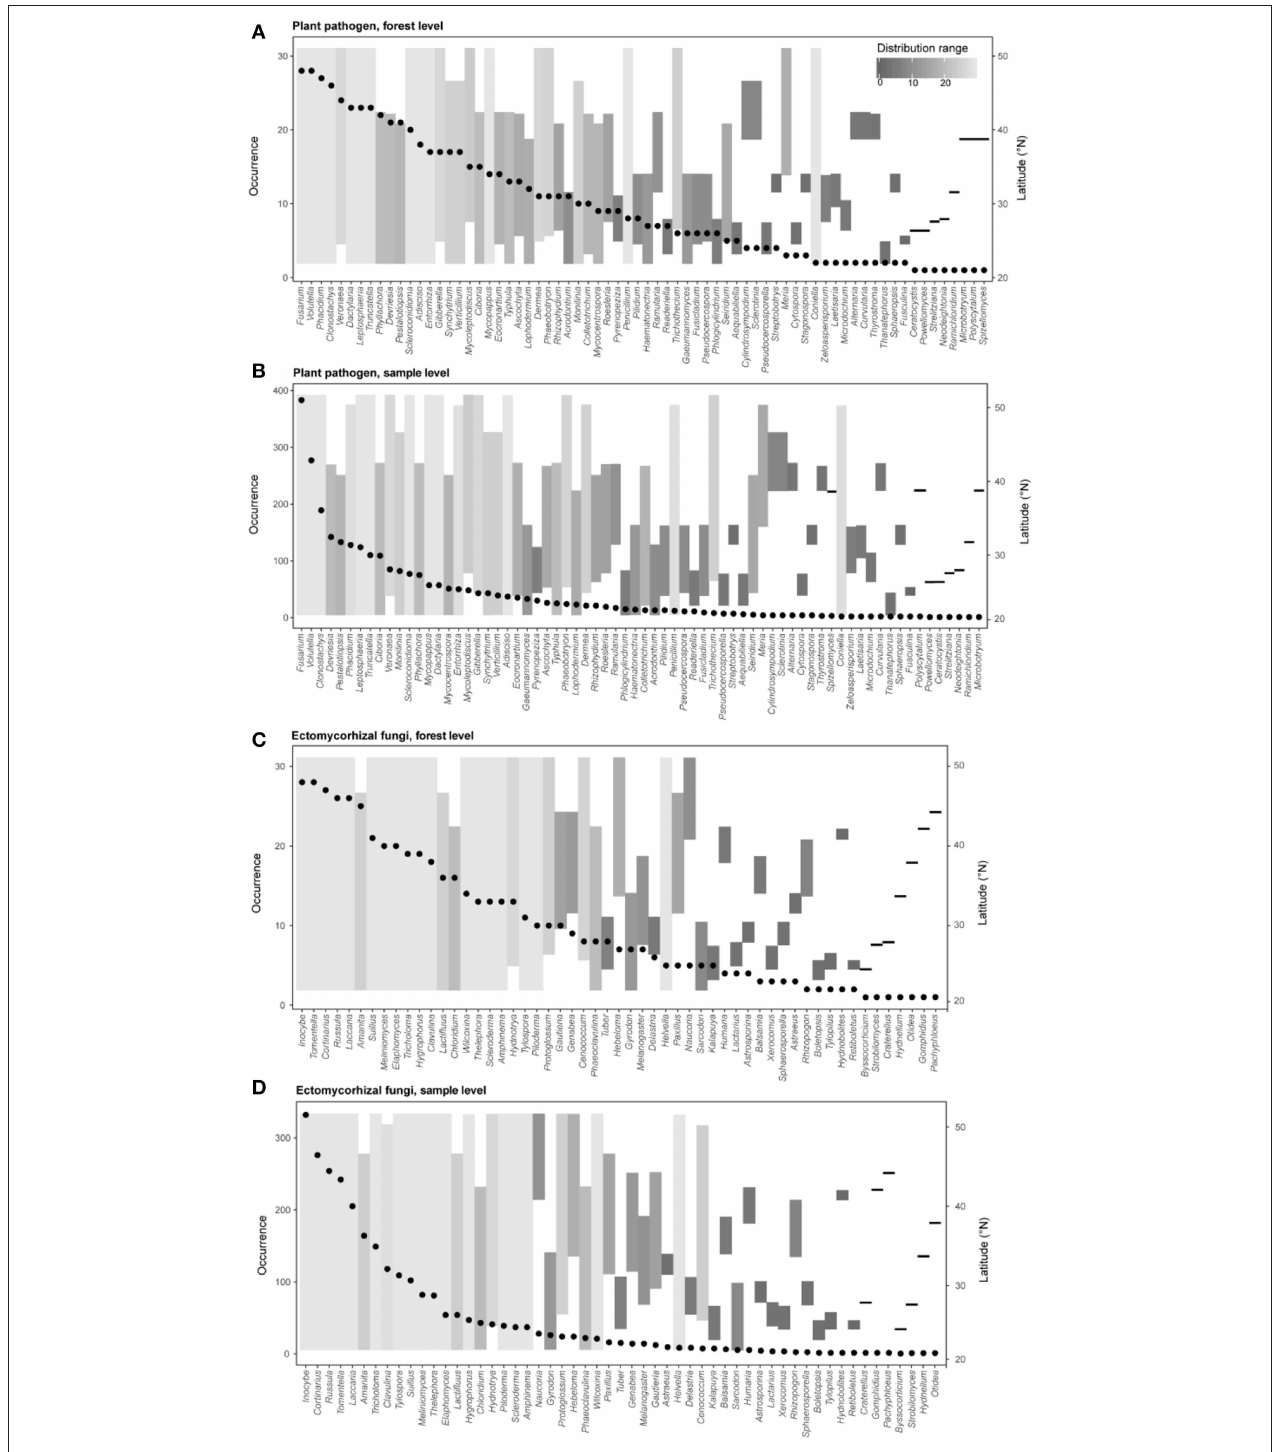
FIGURE 3 | Occurrence frequencies and latitude distribution ranges of different genera of plant pathogens ( A , forest level; B , sample level) and ectomycorrhizal fungi ( C , forest level; D , sample level) in this study. Points represent occurrence number of a given genus (left y-axis) across different forest reserves or all samples. Bar plots show the detected latitude range (right y-axis) and the distribution range (colors) of each fungal genus.